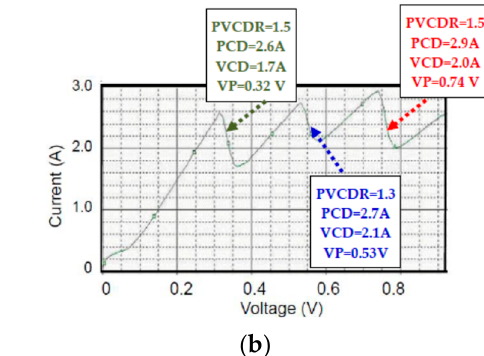
Figure 9. ( a ) The equivalent circuit of triple PVCDR RTEC structure with adding the fourth RTEC unit. ( b ) Symmetry NDR characteristic of triple PVCDR RTEC structure with adding the fourth RTEC unit .